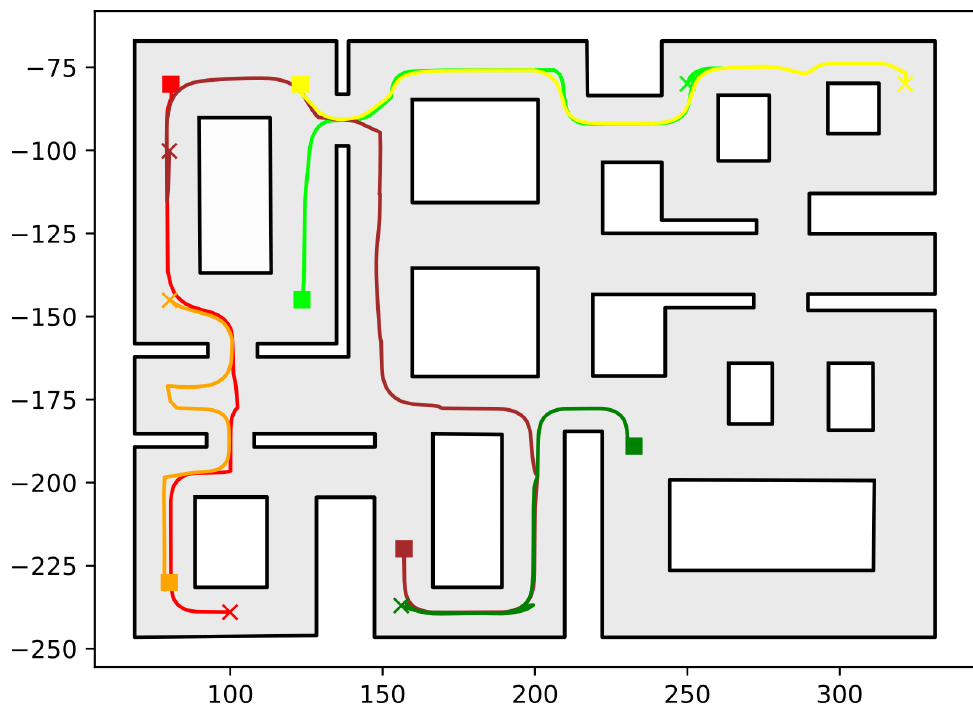
Figure 7. Executed trajectories of the six-robot case. Squares indicate initial positions, whereas the corresponding goal positions are depicted using crosses. Robot #1 (red); Robot #2 (green); Robot #3 (dark red); Robot #4 (orange); Robot #5 (yellow); Robot #6 (dark green). The axes units are in (dm).